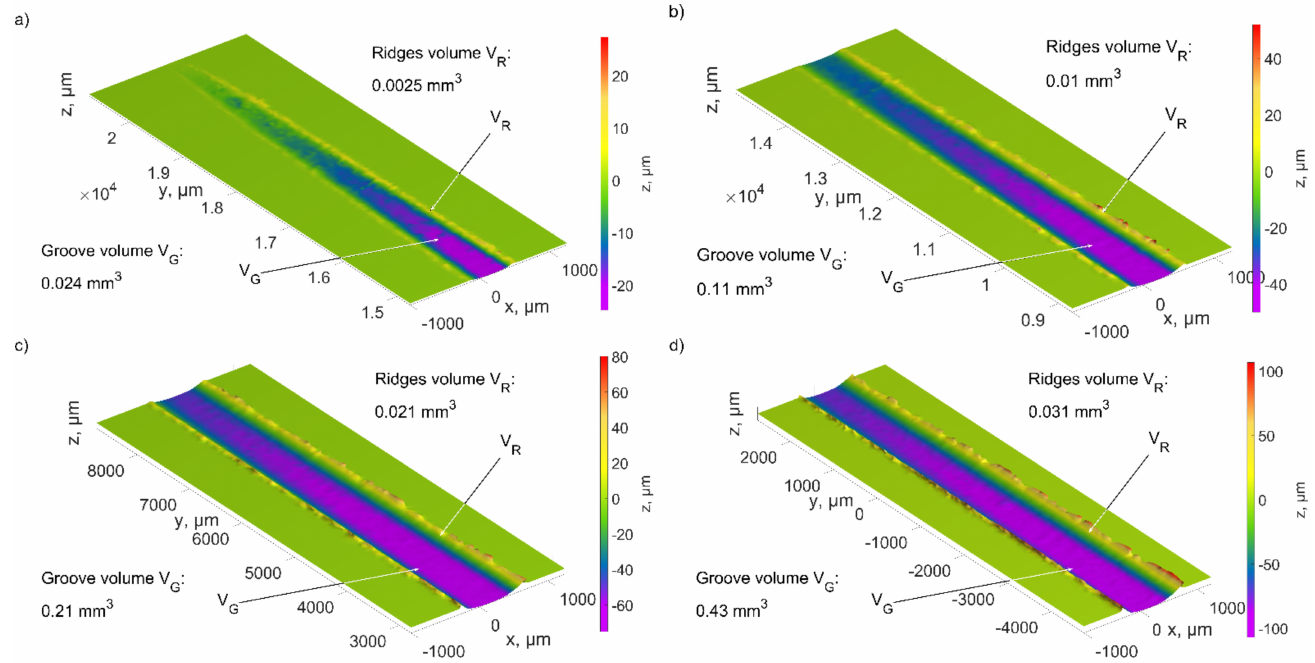
Figure 15. The results of the scratch volume and pile-ups after the ZS2 grain cutting process for the depth of cut: ( a ) from 0 to 25 µ m, ( b ) from 25 µ m to 50 µ m, ( c ) from 50 µ m to 75 µ m, ( d ) 75 µ m to 100 µ m.